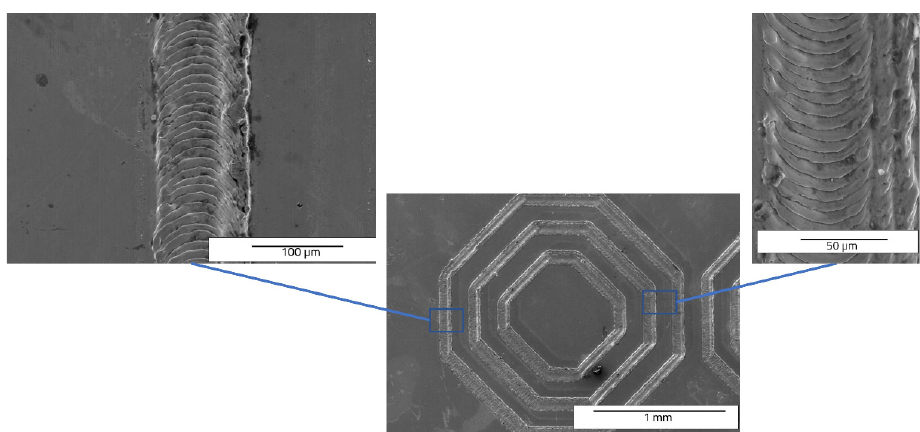
Figure 5. Top view SEM images of octagonal donut shape (design type A) of LST, frequency 30 kHz, speed 300 mm/s, and no. of repetitions 10.